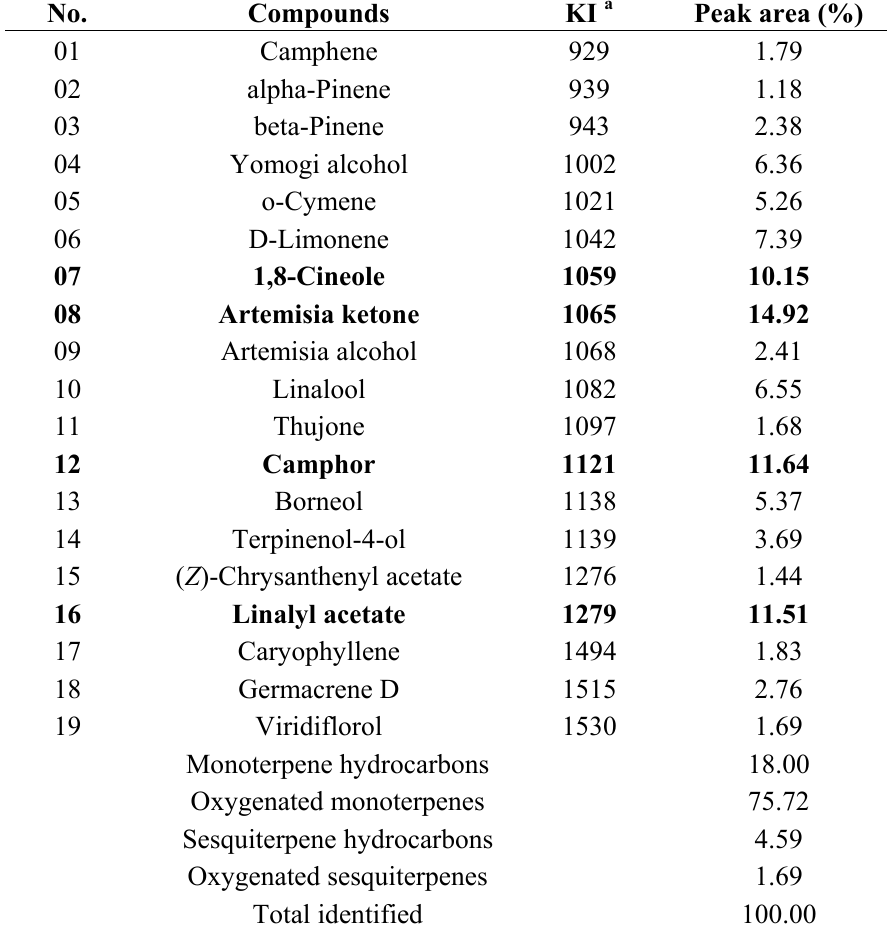
Table 1. Chemical composition of Achillea millefolium L. essential